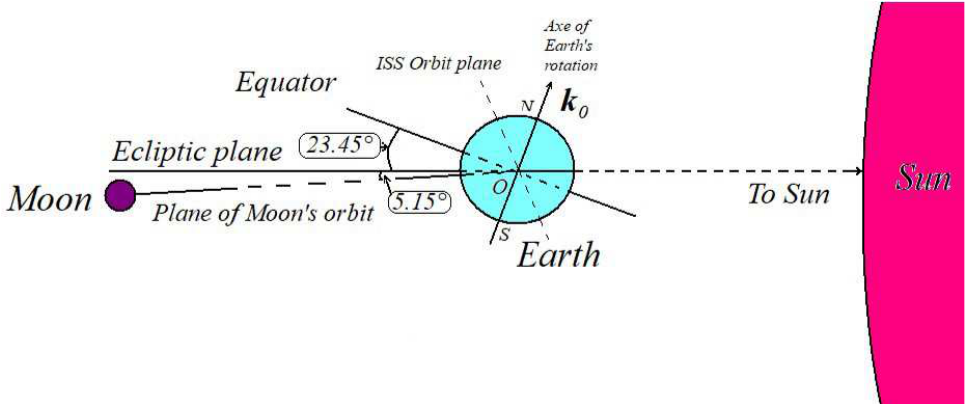
Figure 1. This shematic is not true to scale. The revolution of the Earth takes place around the pole axis k 0 . The orbit of the ISS is indicated in complete dotted